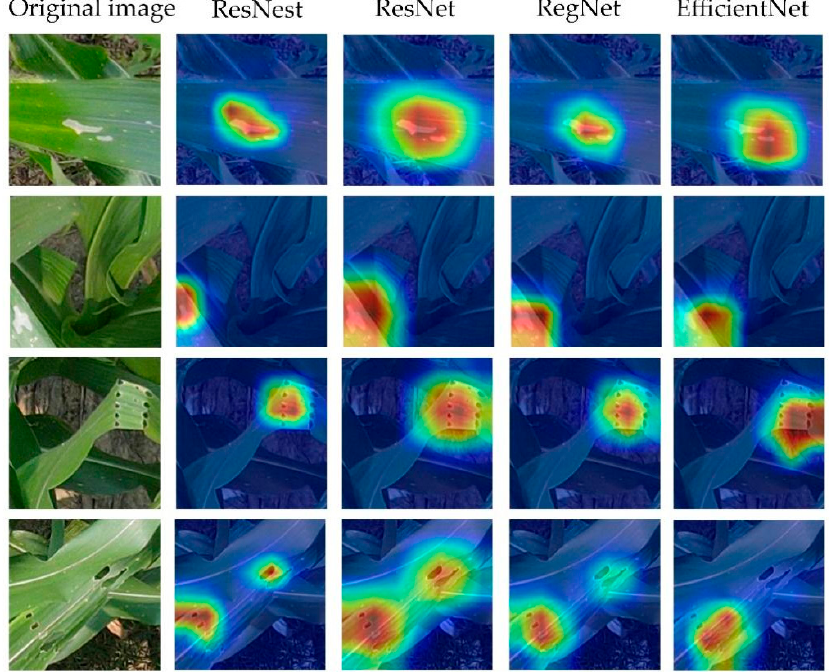
Figure 10. Attention map base on grad CAM.